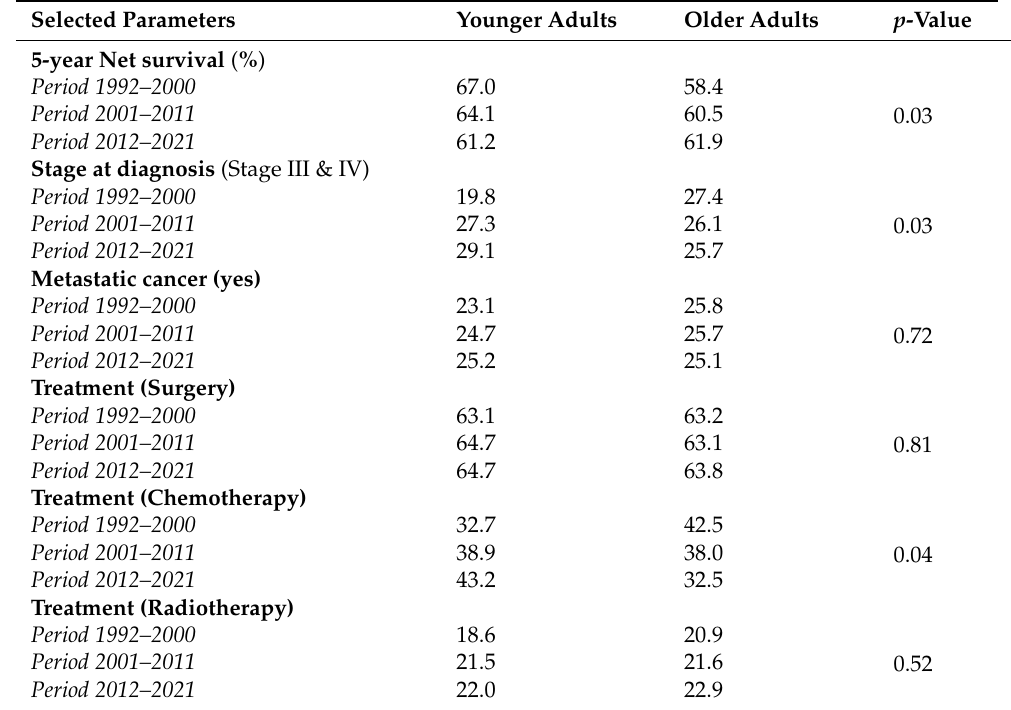
Table 3. Statistical differences on survival, stage at diagnosis, metastatic cancer, and therapeutic approach between younger and older